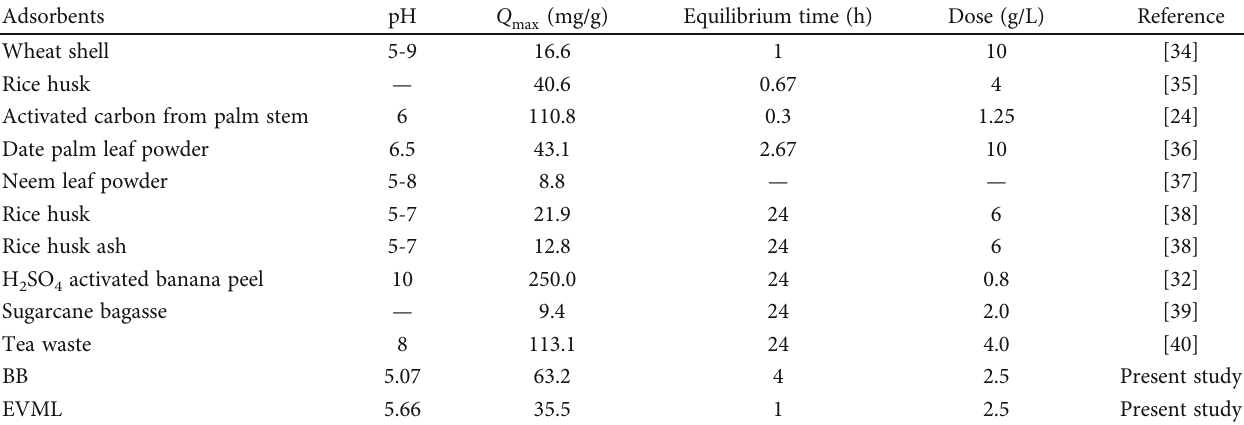
Table 4: The maximum adsorption capacity of some adsorbents for MB adsorption.